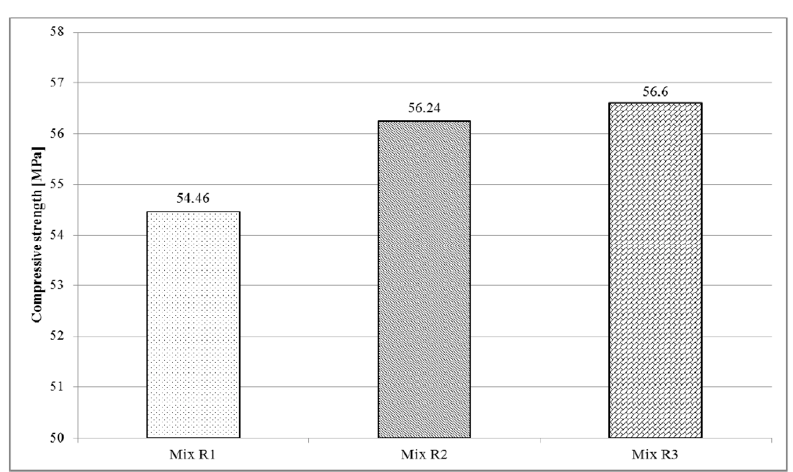
Figure 6. Compressive strength of the test specimens at the end of the beams after 28 days.